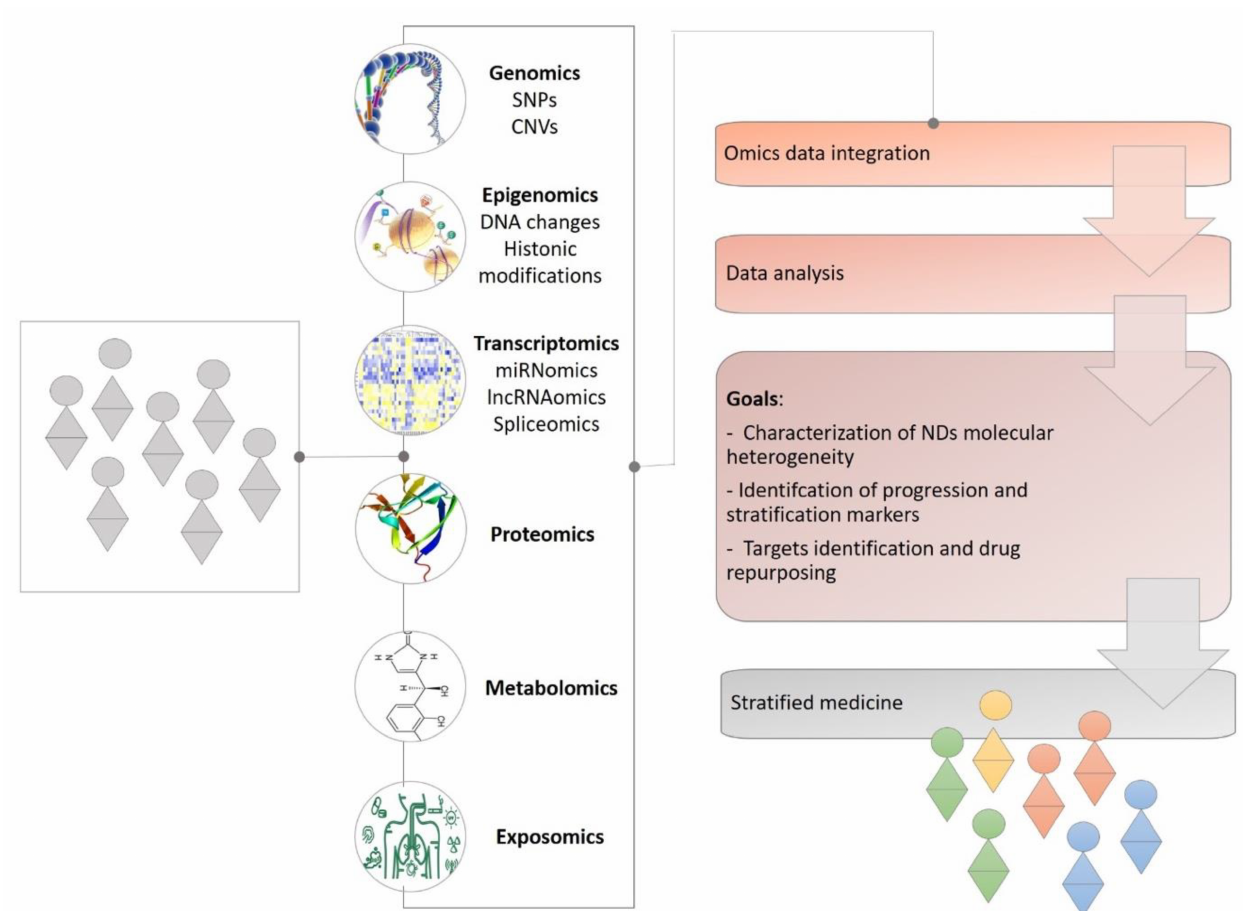
Figure 1. A full readout of ND conditions to support stratified medicine. From the genome onwards, information gathered from all omics molecular layers of NDs conditions will aid researchers and clinicians to better characterize the disease’s molecular heterogeneity, stratify patients by novel biomarkers and improve therapeutic outcomes.